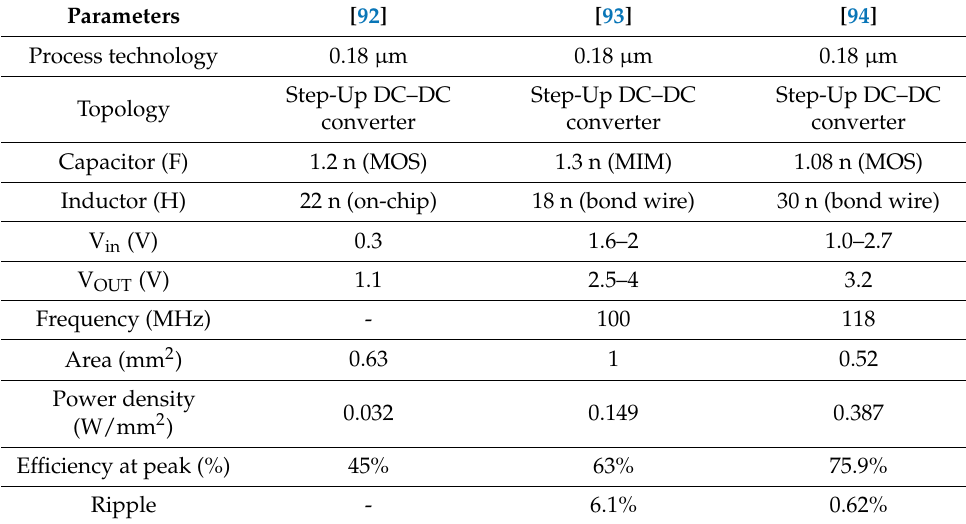
Table 4. Performance comparison of step-up DC–DC converters designs based on on-chip-integrated passive